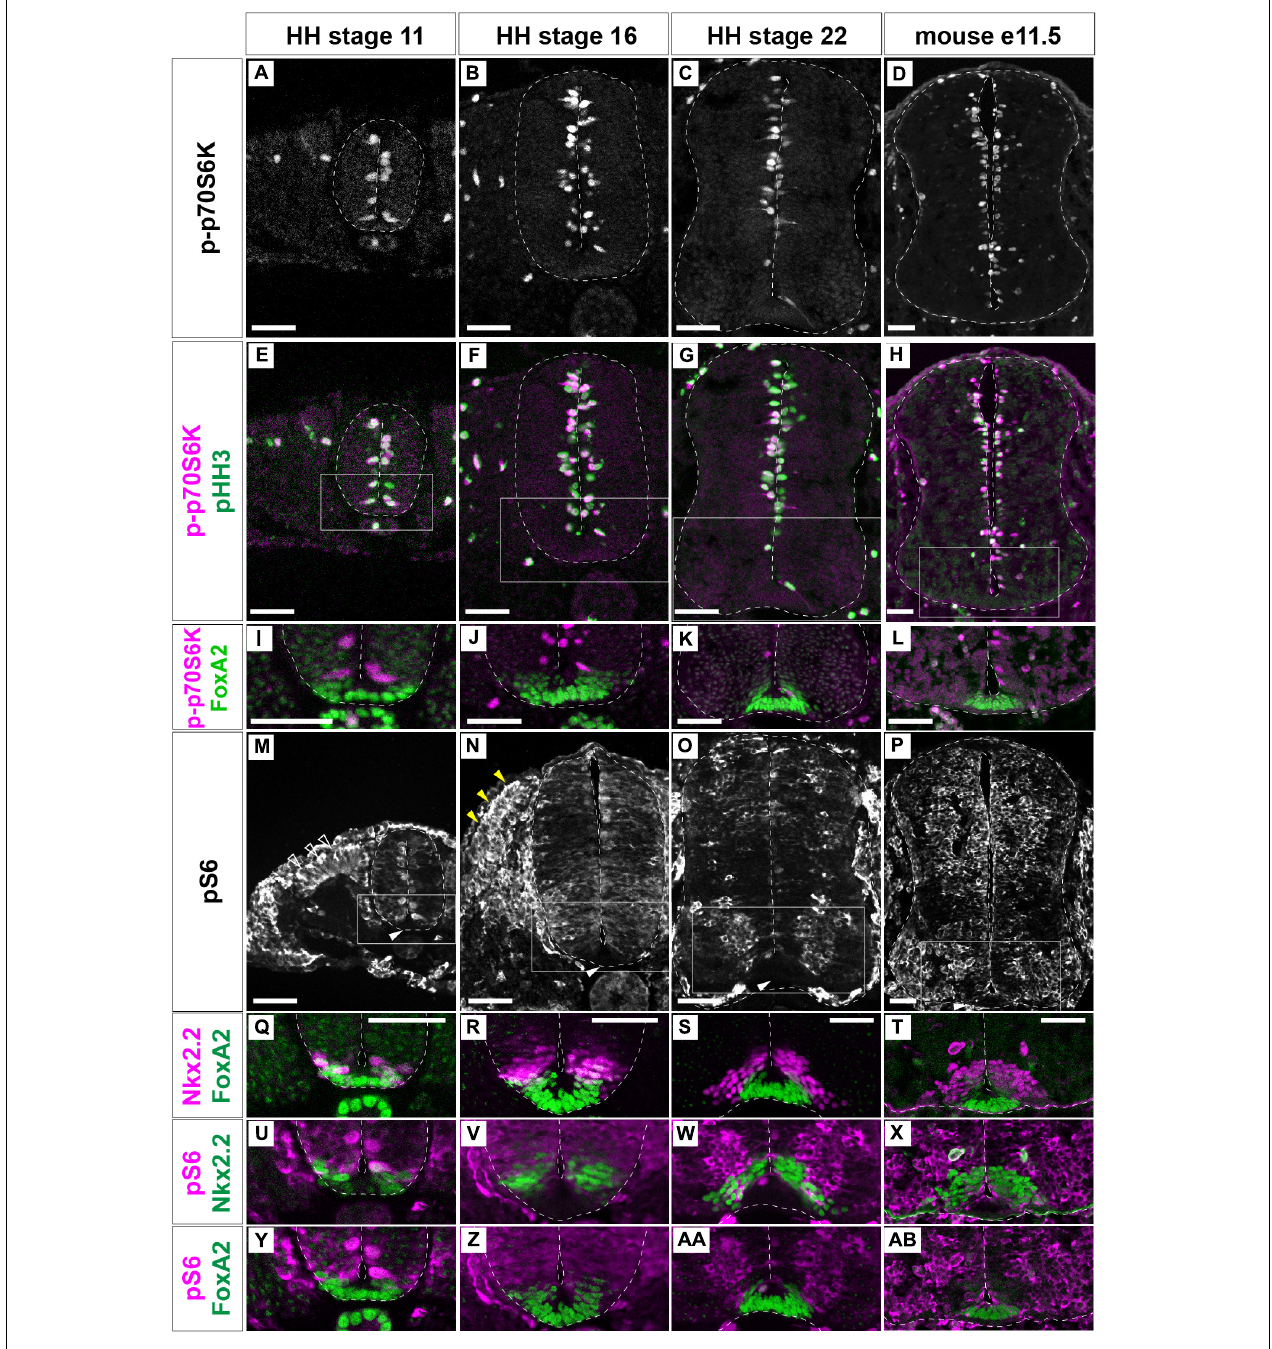
FIGURE 2 | mTOR signal is negative in the floor plate. p-p70S6K (A–L) , pHH3 (E–H) , and FoxA2 (I–L) expression was identified by immunofluorescence at HH stages 11 (A,E,I) , 16 (B,F,J) and 22 (C,G,K) of chick, and at e11.5 (D,H,L) mouse neural tube sections. (M–AB) pS6-positive cells (white, M–P ; and magenta, U–AB ) were analyzed with those of Nkx2.2 (magenta, Q–T ; green, U–X ) and FoxA2 (green, Q–T,Y–AB ). (I–L) correspond to the areas surrounded by rectangles in (E–H) , respectively. (Q,U,Y) , (R,V,Z) , (S,W,AA) , and (T,X,AB) correspond to the areas surrounded by rectangles in (M–P) , respectively. Scale bars = 50 µ m. White arrowheads in (M–P) ; outlined arrowheads in (M) ; dorsal somite, yellow arrowheads in (N) ; dermomyotome.